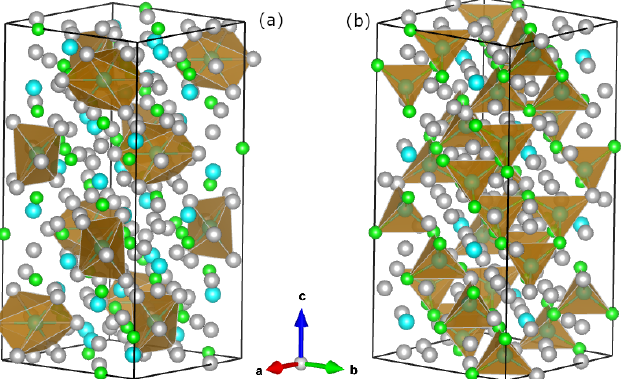
Figure 1. The unit cell of R 5 Rh 6 Sn 18 compound. The polyhedra show the nearest local environment of the R 1 ( a ) and R 2 ( b ) sites. The grey, green, and blue spheres represent Sn, Rh, and R atoms ( R = Sc, Lu, Y),